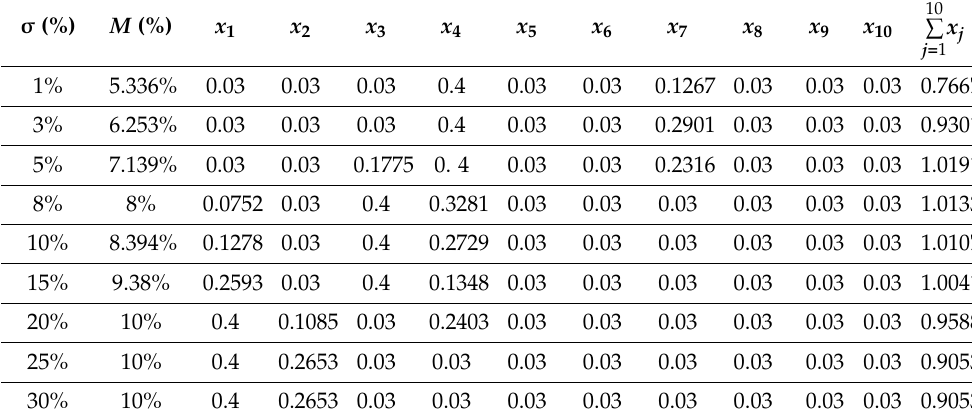
Table 10. The possibilistic efficient portfolios with b = 0.1, p 1 = 0.3, p 2 = 0.2, p 3 = 0.2. σ